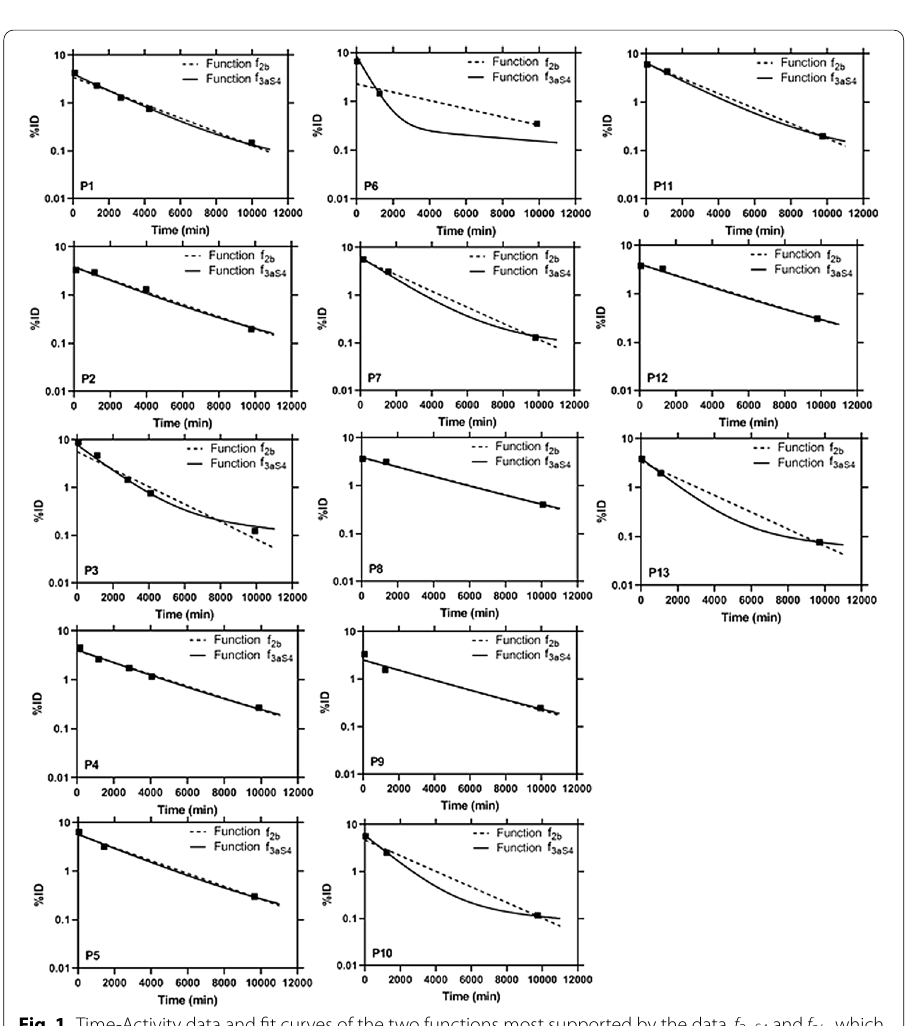
Fig. 1 Time-Activity data and fit curves of the two functions most supported by the data, f 3 aS 4 and f 2 b , which were derived using the PBMS and IBMS method, respectively